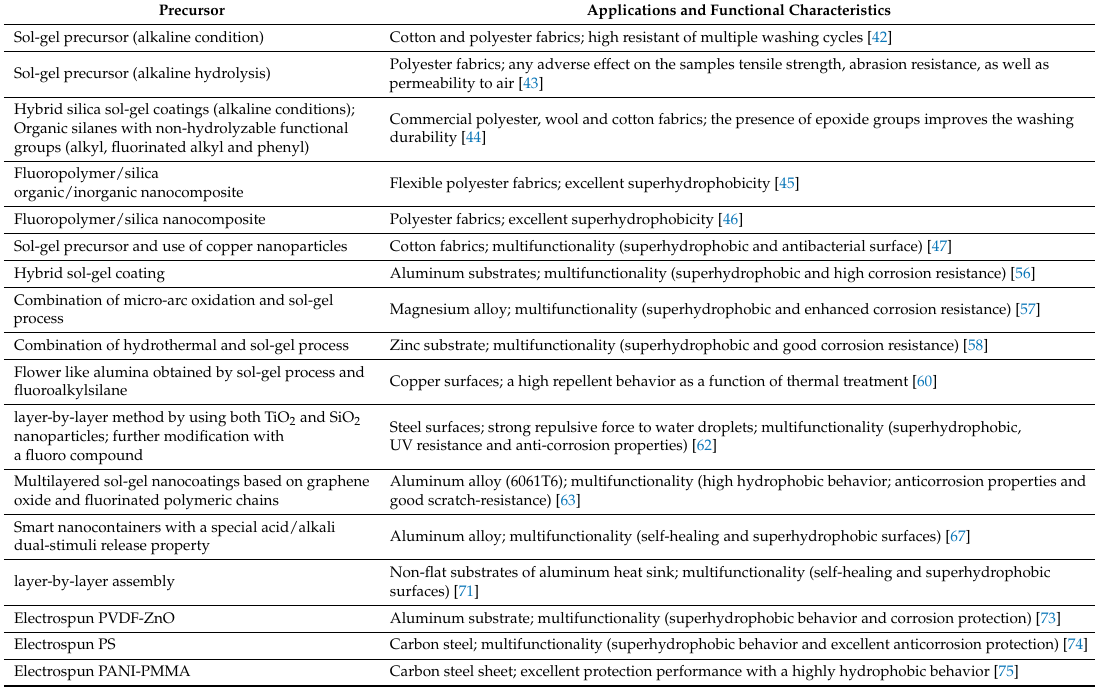
Table 2. Summary of the design of superhydrophobic or highly hydrophobic surfaces in the field of functional textiles and metallic substrates for the design of anticorrosive